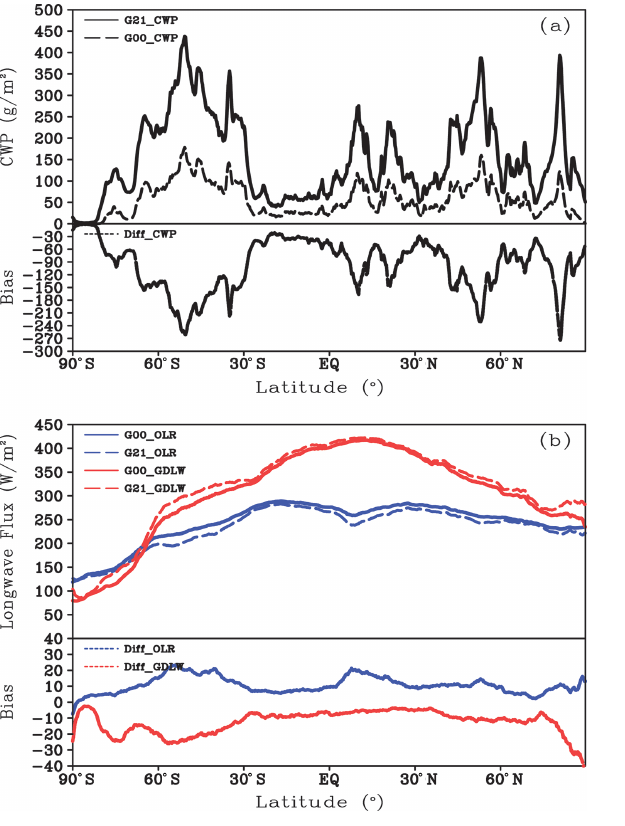
Figure 7. Zonal means and their differences of (a) 3h-averaged cloud water path (CWP), and (b) the outgoing longwave (OLR) at the top of atmosphere and the downward longwave at ground (GDLW) simulated by G21 and G00 experiments for 00:00– 03:00UTC, 9 August 2019. The units of CWP and OLR/GDLW are gm − 2 and Wm − 2 ,